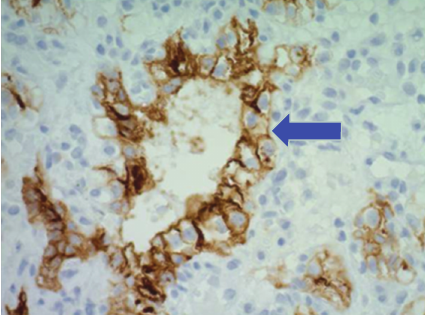
Figure 3: Immunostaining showing cancer cells staining positive for CD10.